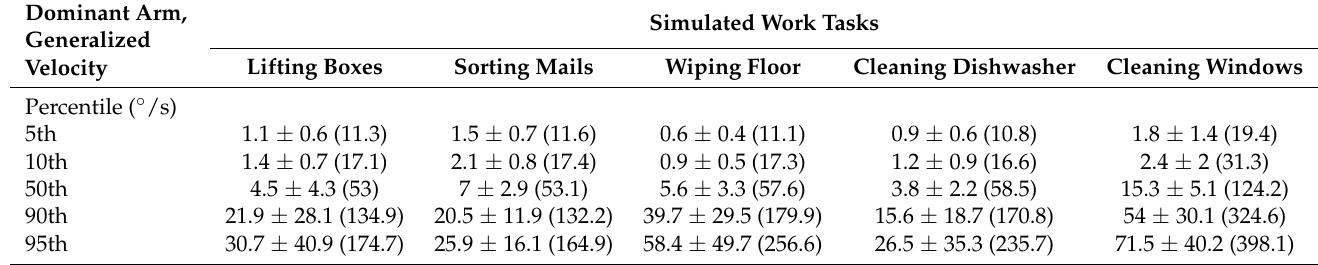
Table A3. The mean ± standard deviation of the mean absolute errors (MAEs) of the dominant arm generalized velocity between cloth sensors and skin sensors during the five simulated tasks, with the reference value of skin sensors shown in brackets ( n = 12).